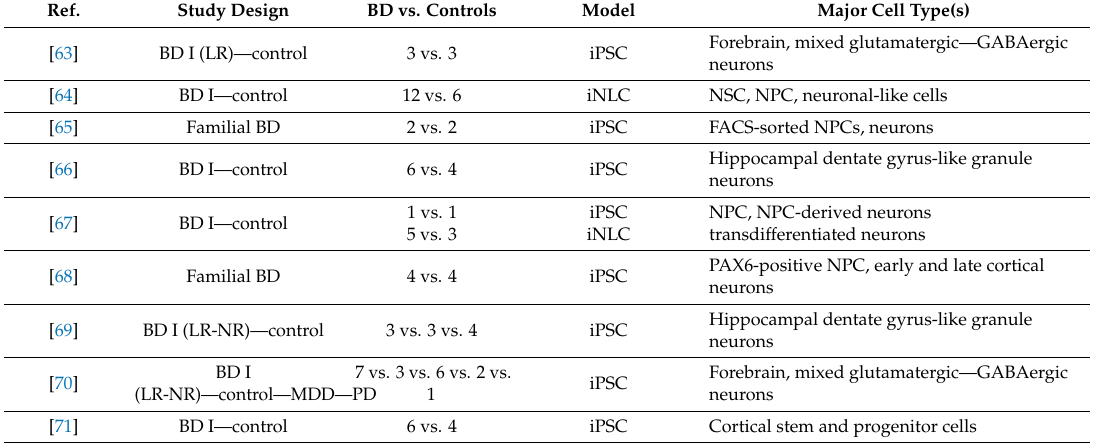
Table 2. Study design, cellular model, and neuronal cell types.